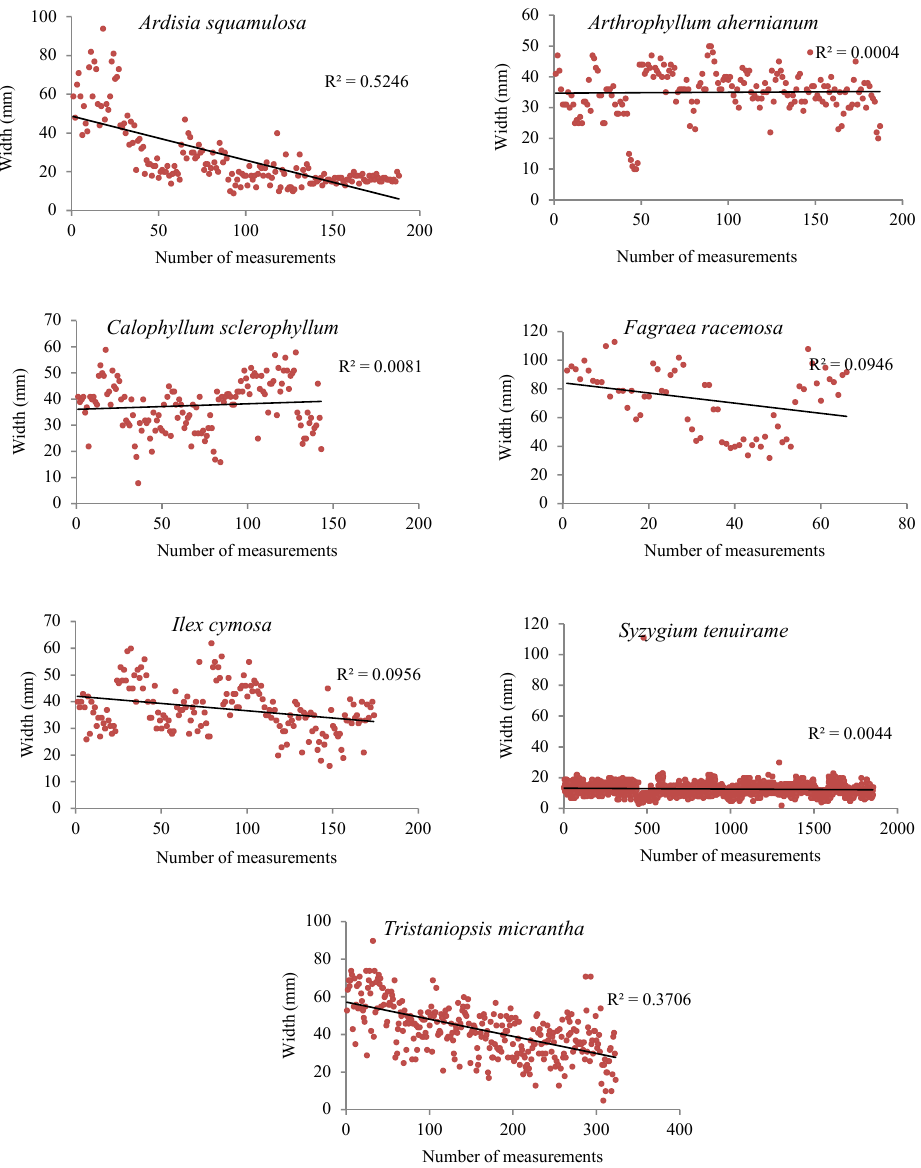
Fig. 4: Variation of leaf widths of all the species used